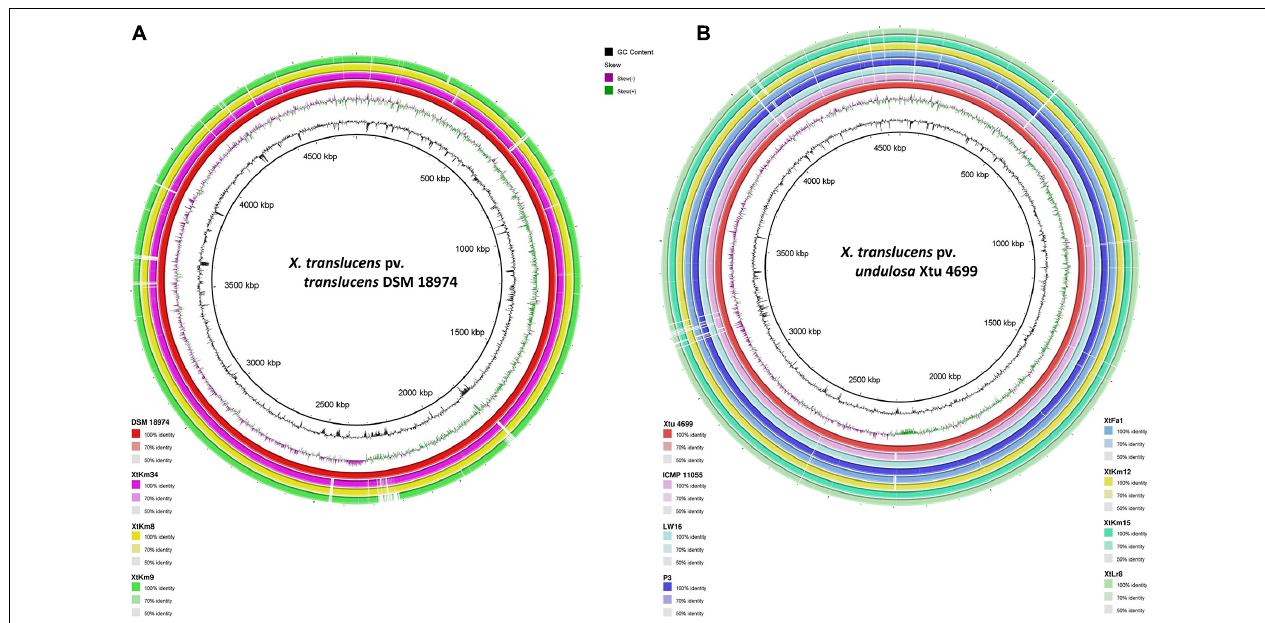
FIGURE 3 | Pairwise genome collinearity alignment of the seven Xanthomonas translucens strains sequenced in this study performed using BRIG 0.95. The genomes of DSM 18974 T (A) and Xtu 4699 (B) were used as reference genomes for X. translucens pv. translucens and X. translucens pv. undulosa strains,